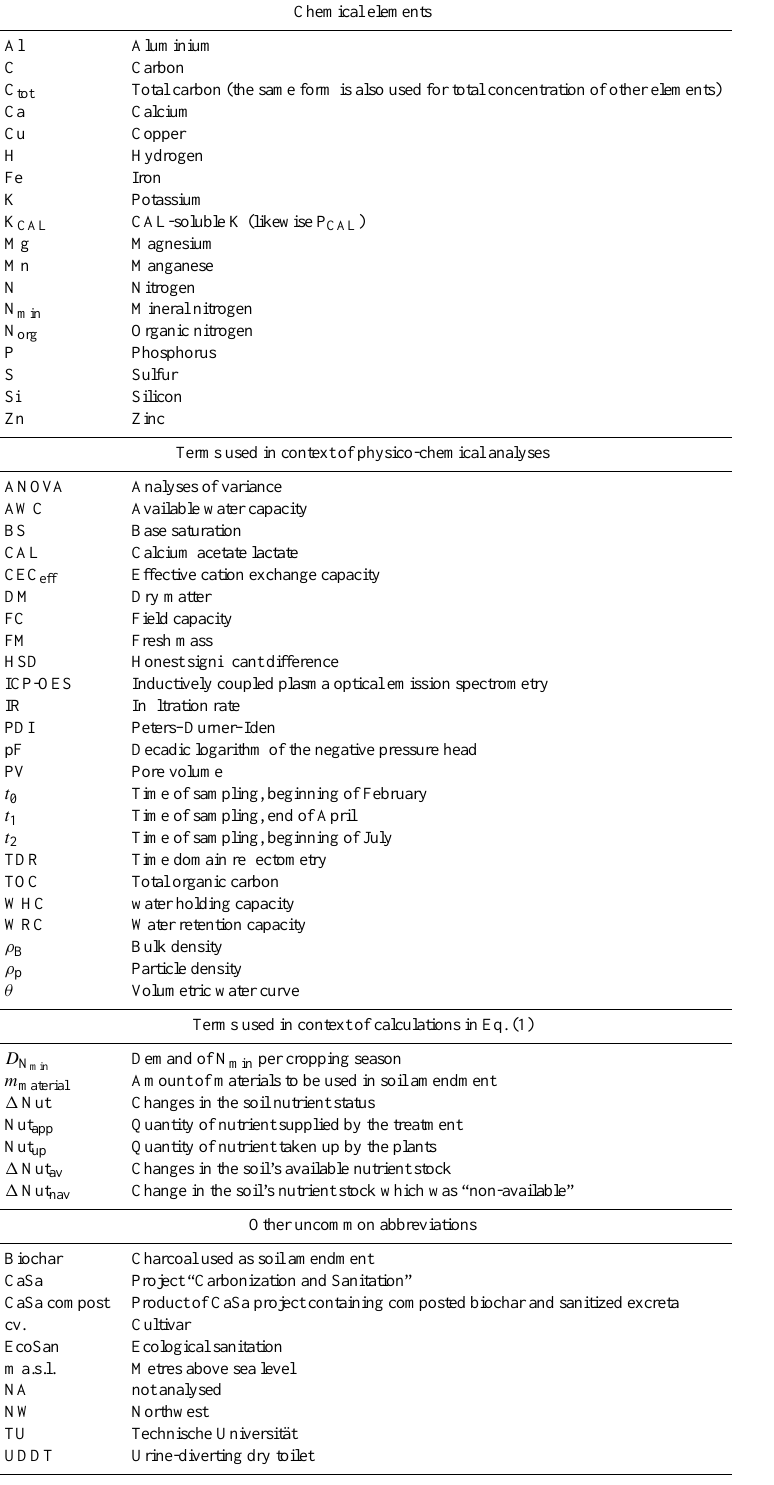
Table A1. List of